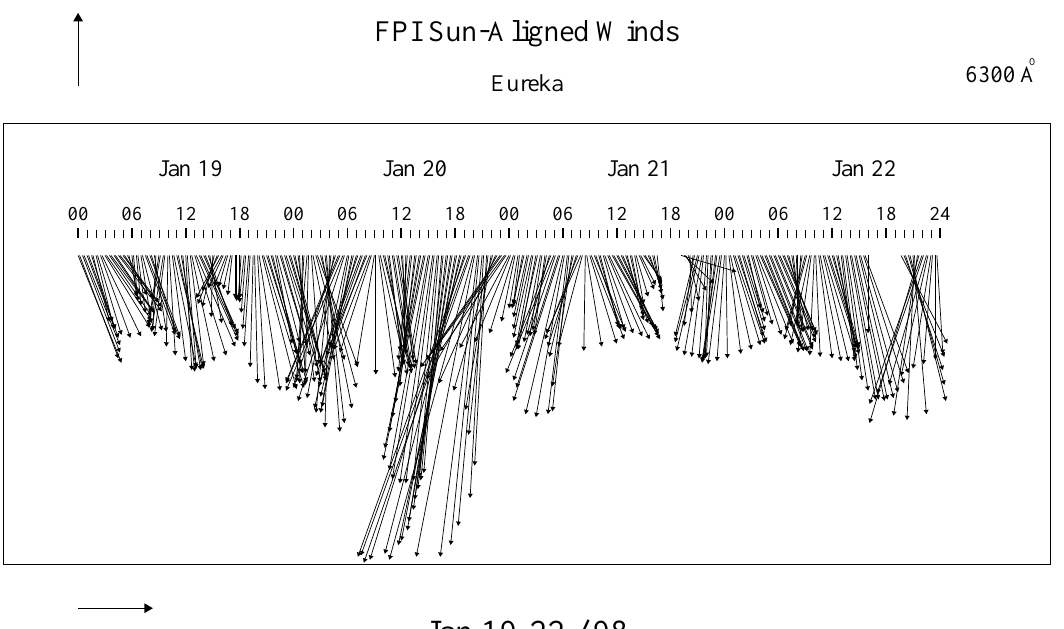
Fig. 15. Eureka FPI (630.0 nm) F-region neutral wind vectors recorded over a 4-day period from January 19 to 22, 1998. They are plotted relative to the Sun-Earth direction with Sunward vertically upward. The velocity scale is illustrated by a 100 m/s vector at the